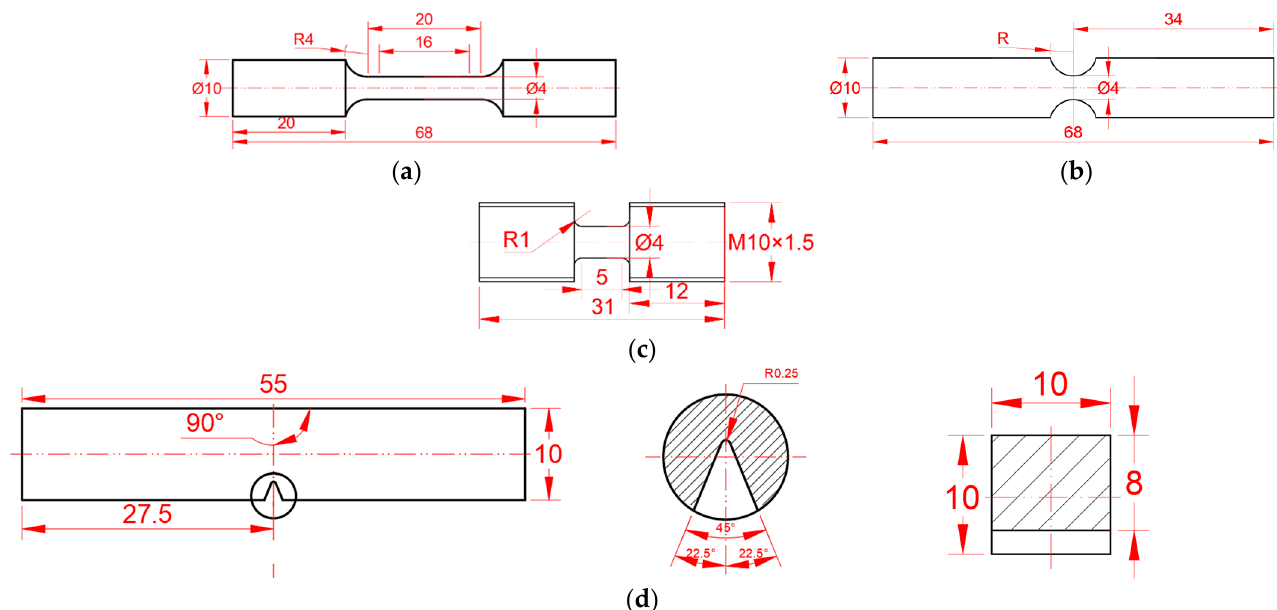
Figure 1. Geometry and dimensions (in mm) of each type of specimen. ( a ) Static smooth round tensile bar [32]; ( b ) Notched round tensile bar (R = 3, 4, and 9 mm) [12]; ( c ) Dynamic round tensile bar [33]; ( d ) Standard Charpy sample [12].